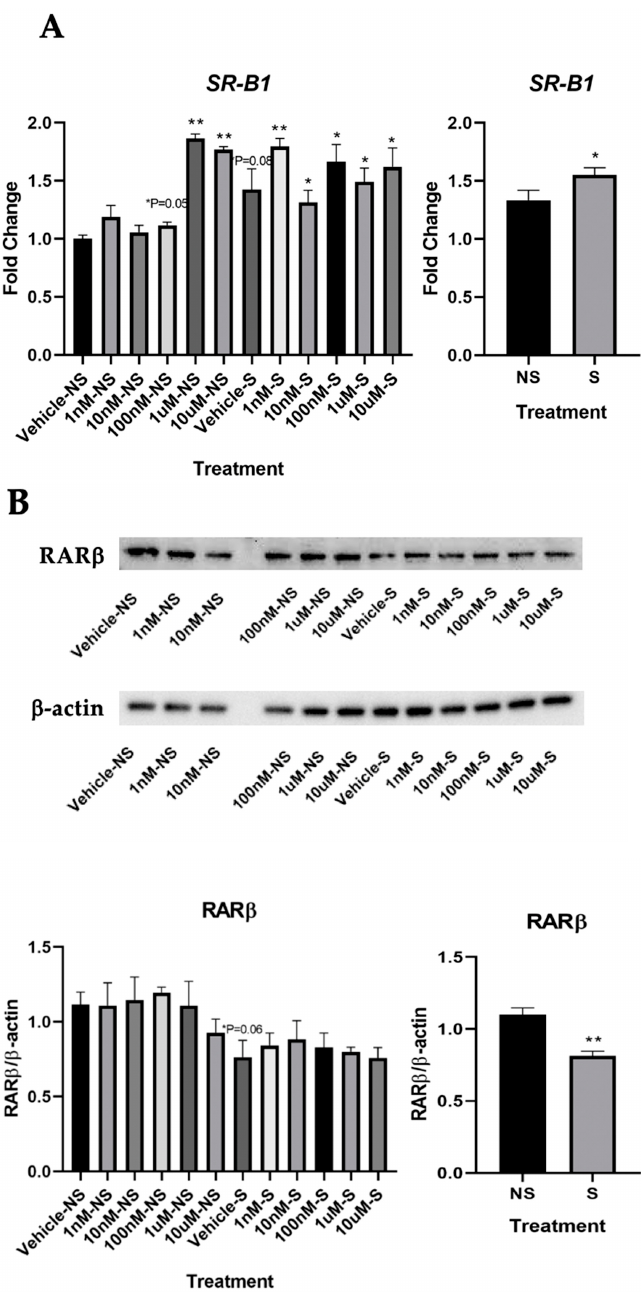
Figure 4. Effects of lycopene treatment at 1 nM, 10 nM, 100 nM, 1 μ M and 10 μ M for 24 h on carotenoid uptake and signaling pathway. Graphic representation of fold changes in: ( A ) mRNA level of SR-B1 and ( B ) protein levels of RAR β . Three replicates were used for statistical analysis. Values are means ± SEMs. NS—cells not exposed to smoke; S—cells exposed to smoke; cells treated with vehicle. Student’s t test was used to compare protein expressions between lycopene-treated cells and vehicle- treated cells; * indicates significance at p < 0.05 compared with the cells not exposed to smoke treated with vehicle; ** indicates significance at p < 0.01 compared with the cells not exposed to smoke treated with vehicle; # indicates significance at p < 0.05 compared with smoking. Two-way ANOVA was used to compare protein expressions between the cells exposed to smoke and the cells not exposed to smoke, * indicates significance at p < 0.05 compared with the cells exposed to smoke; ** indicates significance at p < 0.01 compared with the cells not exposed to smoke.